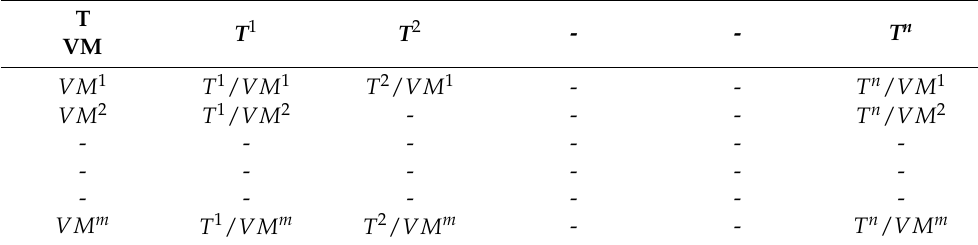
Table 1. Expected time of completion (ETC)